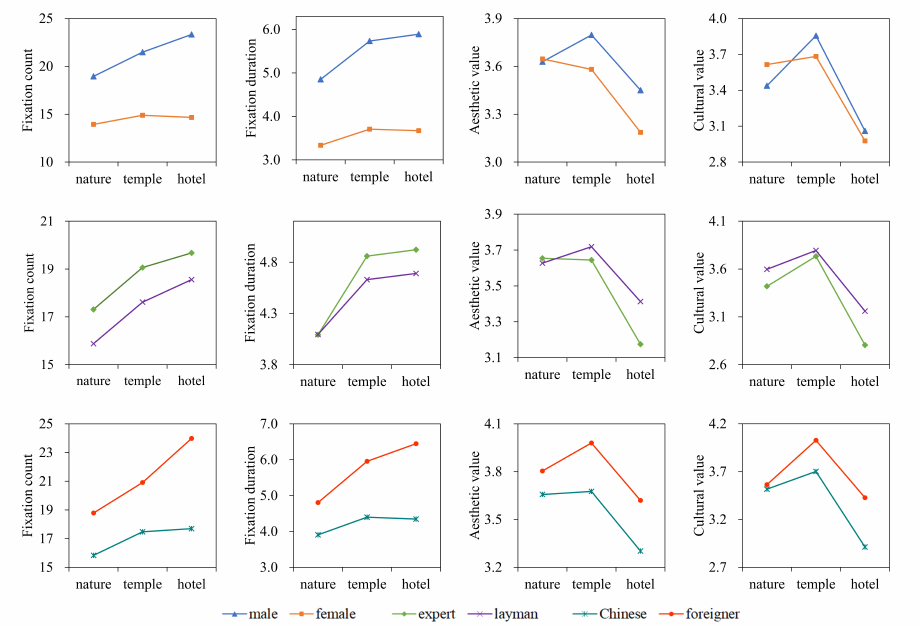
Figure 6. Mean values of eye movement and landscape assessment under gender, expertise, and nationality. The fixation count is measured in counts (c), and the fixation duration is measured in seconds